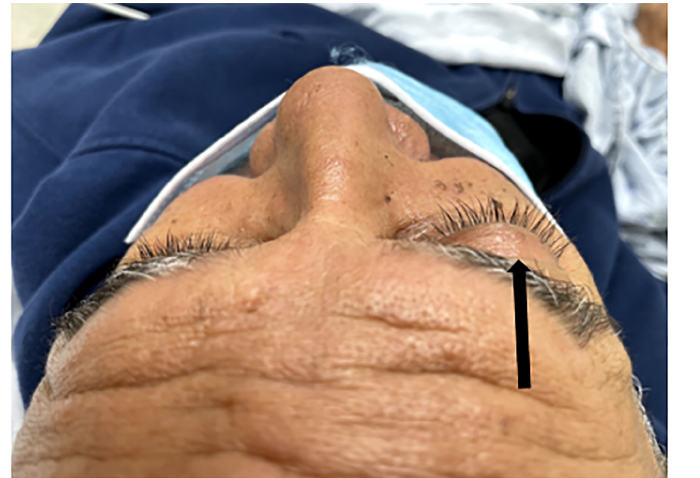
Image 2. Proptosis of the right eye as visualized from above (arrow) in a case of carotid-cavernous fistula.